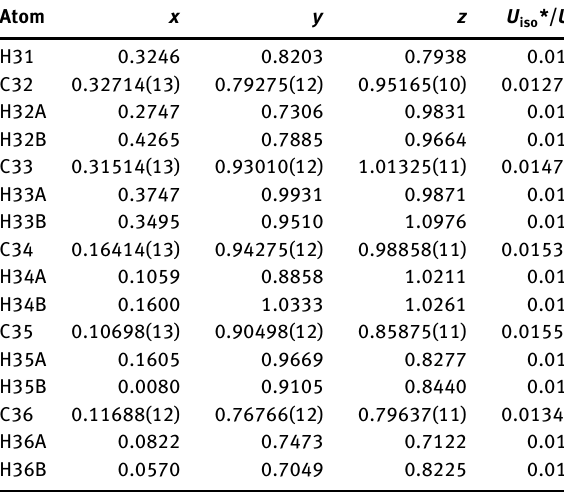
Table 2: Fractional atomic coordinates and isotropic or equivalent isotropic displacement parameters (Å 2